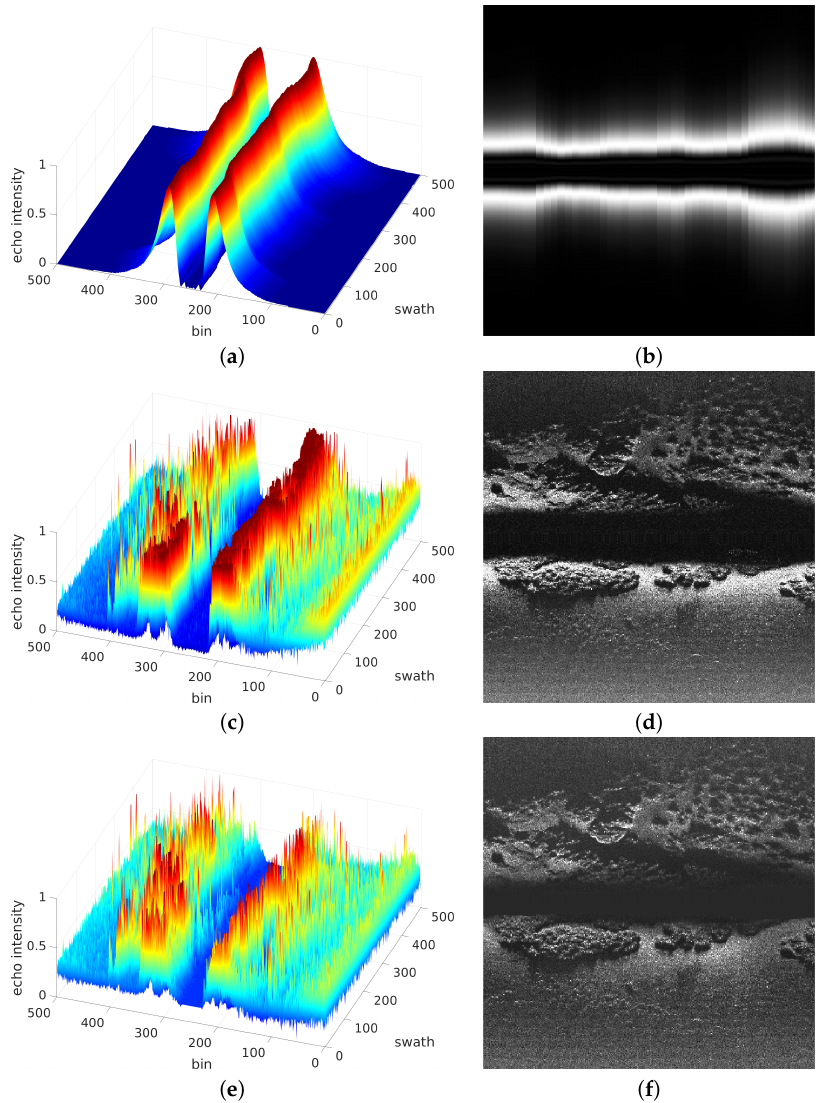
Figure 11. Example of data processing. ( a , b ): Modelled echo intensity E ( p ) according to Equation (5). ( c , d ): Raw SSS data. ( e , f ): Intensity and slant corrected acoustic